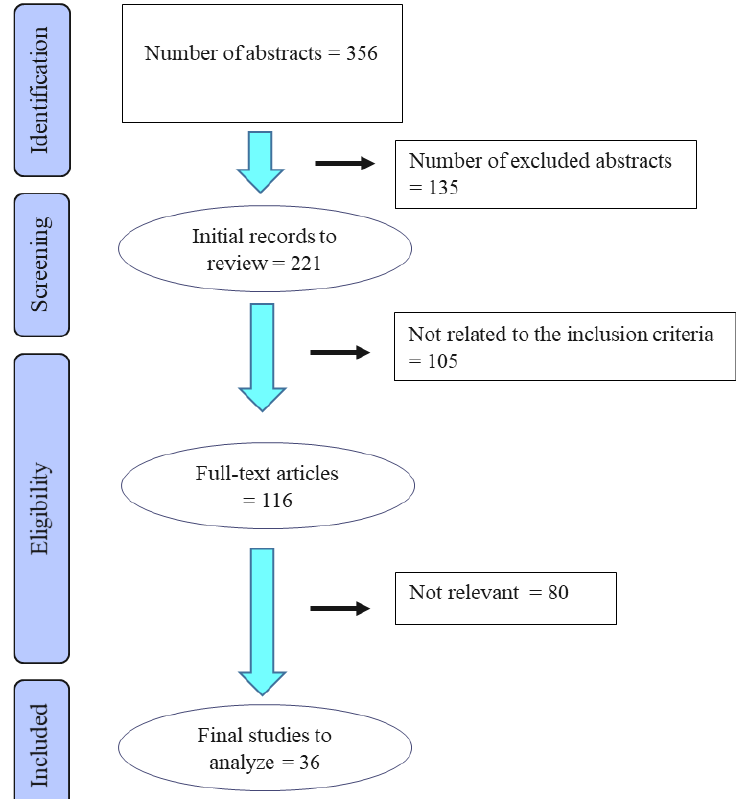
Figure 1 . Flow diagram of the stages of the selection process used for identification of studies eligible for final analysis.